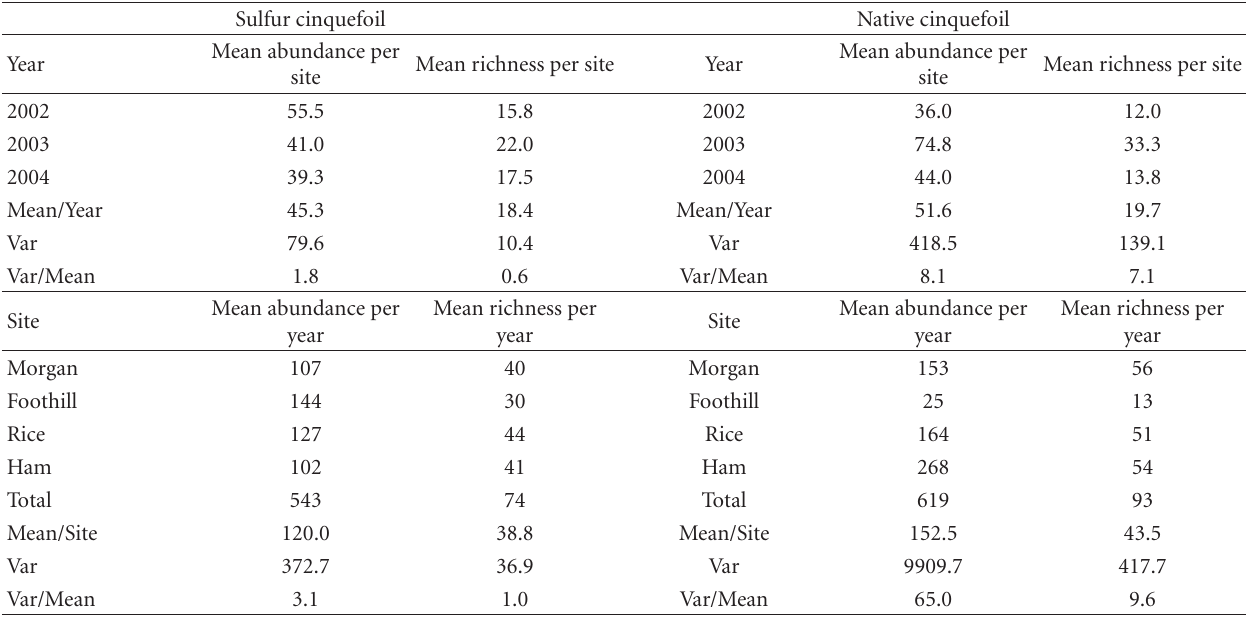
Table 3: Summary data for pollinator surveys for sulfur and native cinquefoil at four sites in northeastern Oregon, 2002, 2003, and 2004. Sulfur